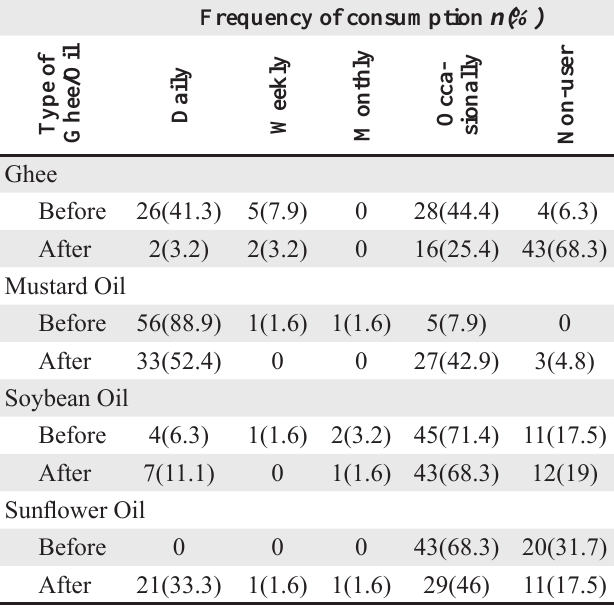
Table 4 : distribution of respondents according to type of fats consumption before and after diagnosis of hypertension